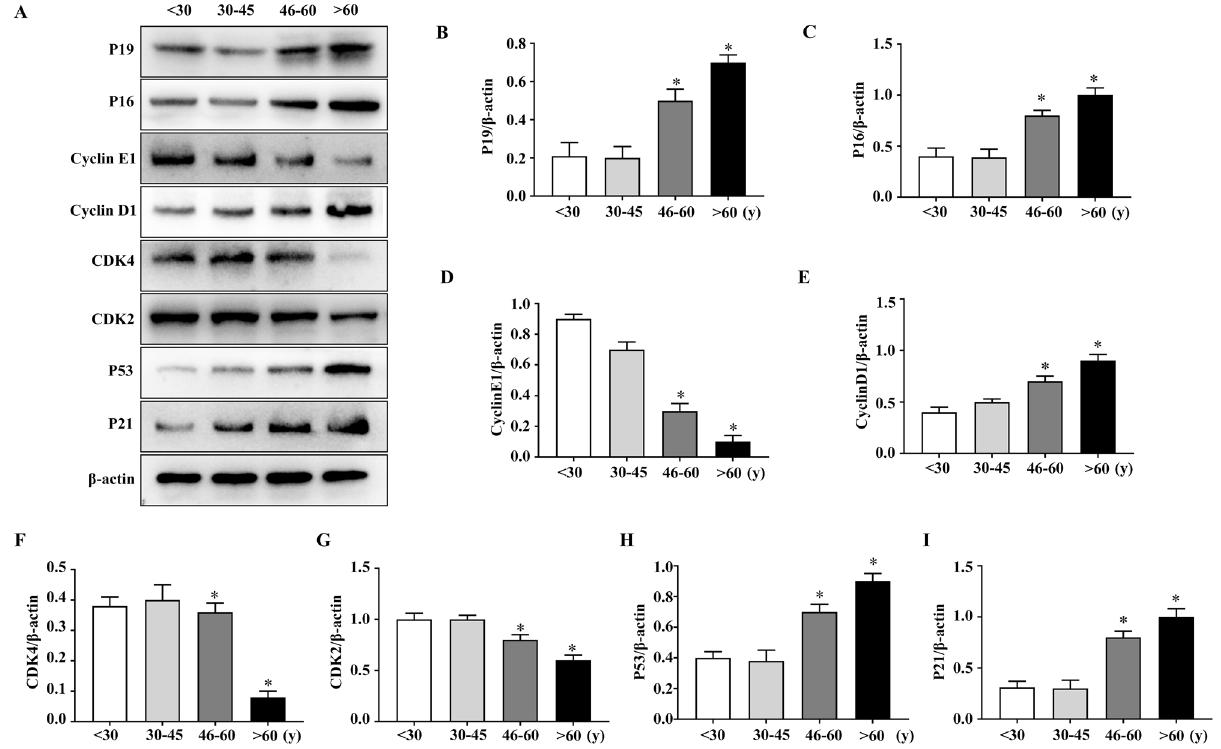
Figure 5. Differences in the expression levels of several key regulatory proteins in hBMHCs from different age groups. ( A ) P16, P53, P21, CyclinD1, P19, CDK2, CyclinE1 and CDK4 expression levels were detected by western blot analysis, full-length blots are presented in Supplementary Figure S1. ( B–I ) Graphical representation of western blot results in each sample group. * p < 0.05: when compared with the < 30 years